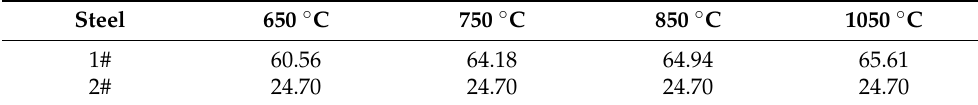
Table 5. SFE of 1# steel under solid solution treatment at different temperatures (mJ/m 2